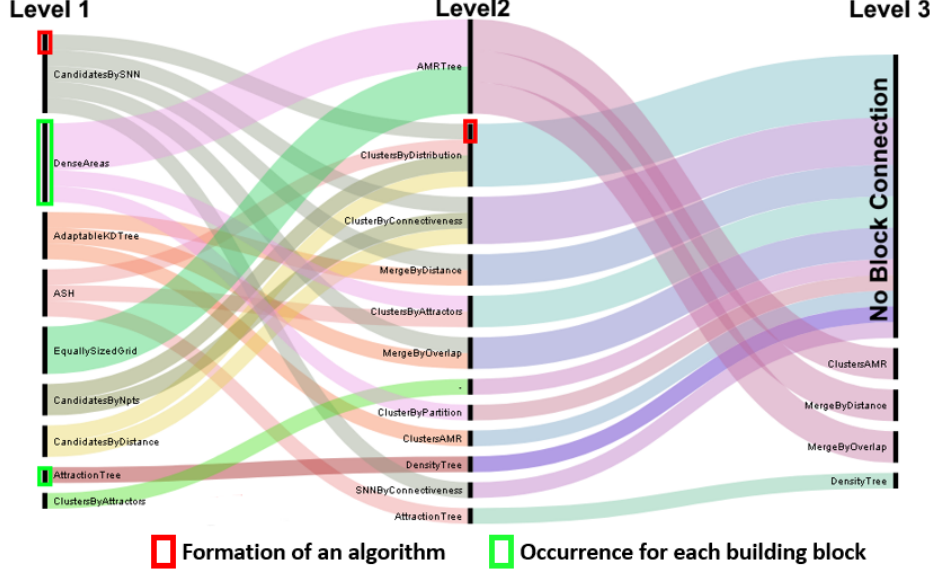
Figure 2. Alluvial visualization organized by occurrence order of each block considering all the